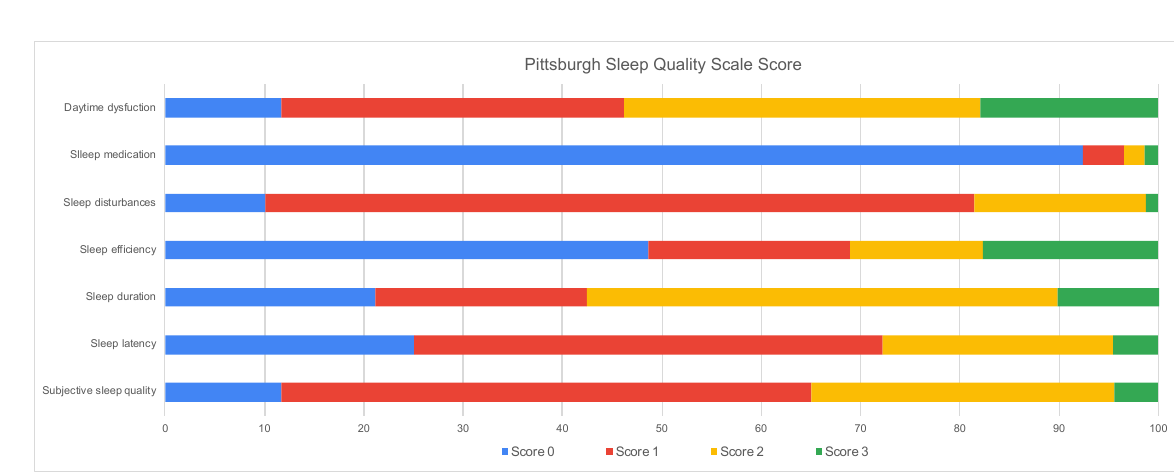
Table 3. Poisson regression to determine the factors associated with poor sleep quality in the study population.